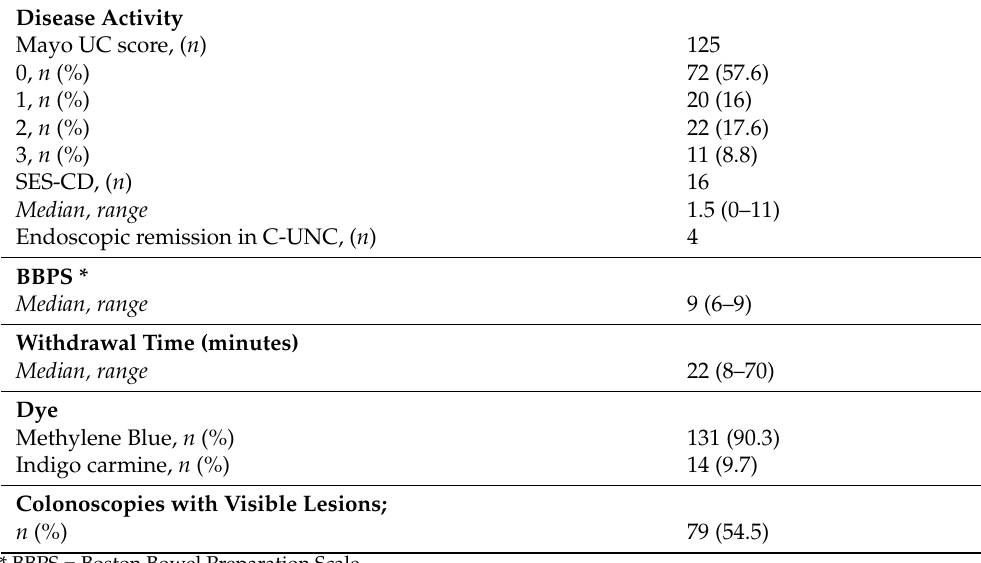
Table 2. Endoscopic characteristics of the patients undergoing